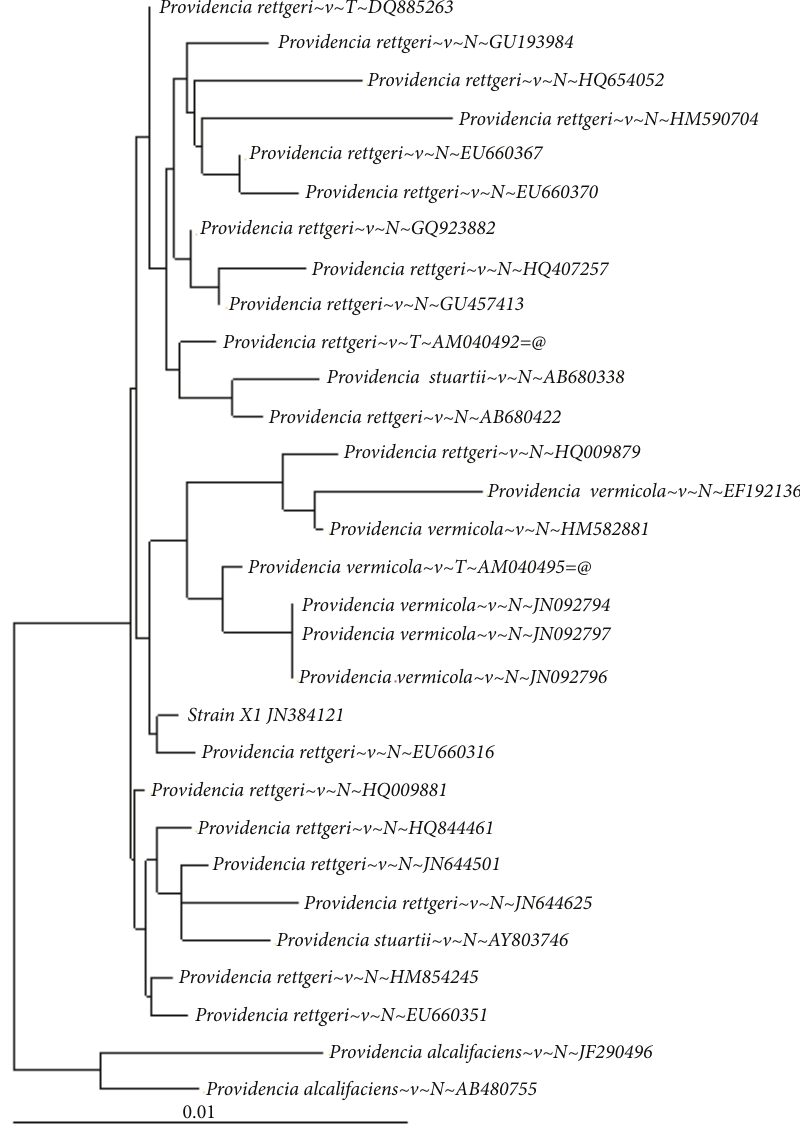
Figure 1: Phylogenetic tree of the Providencia sp. strain X1 and their related genera has been linked based on 16S rRNA sequence